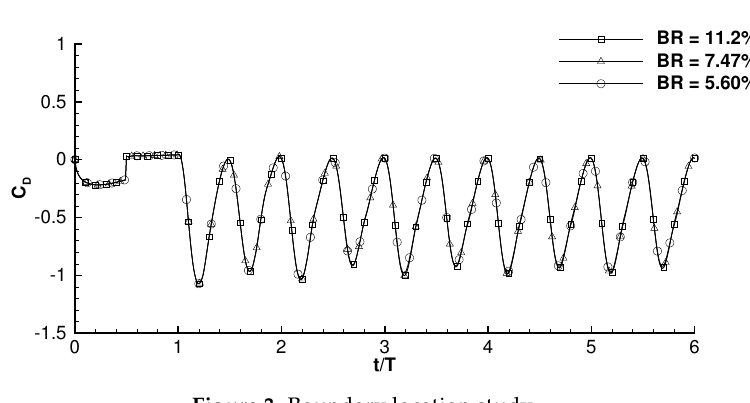
Figure 3. Boundary location study.